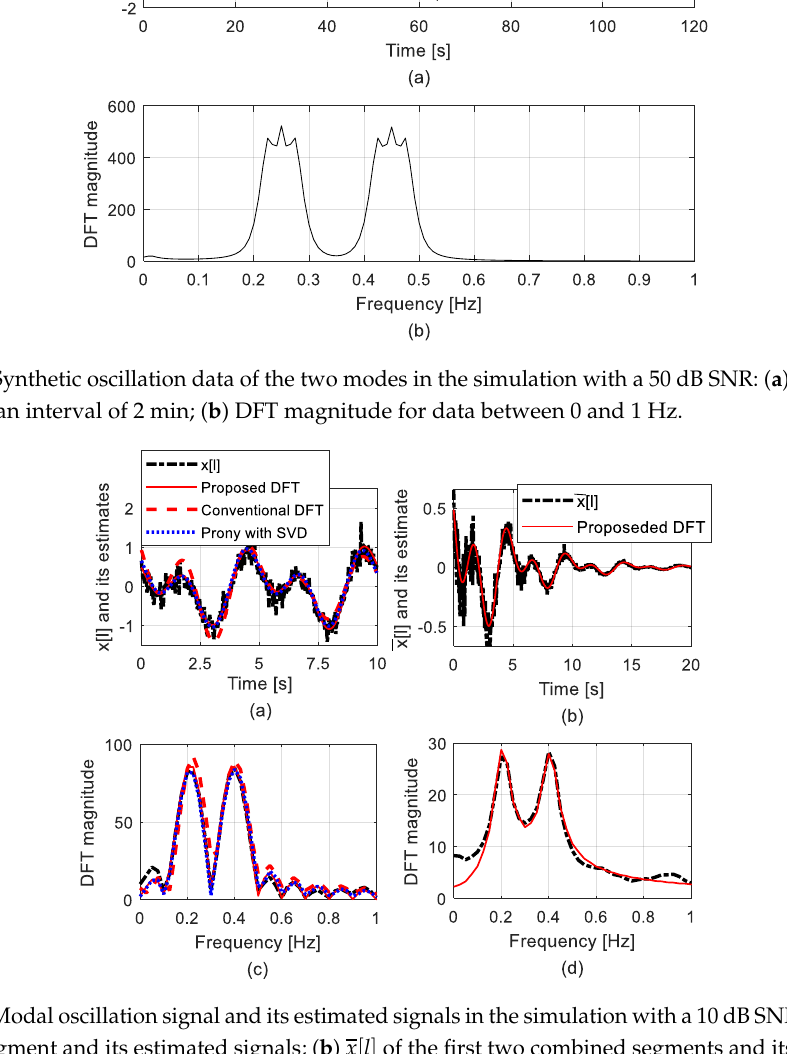
Figure 3. ESRs of the three methods in the simulation: ( a ) 50 dB SNR; ( b ) 10 dB SNR.